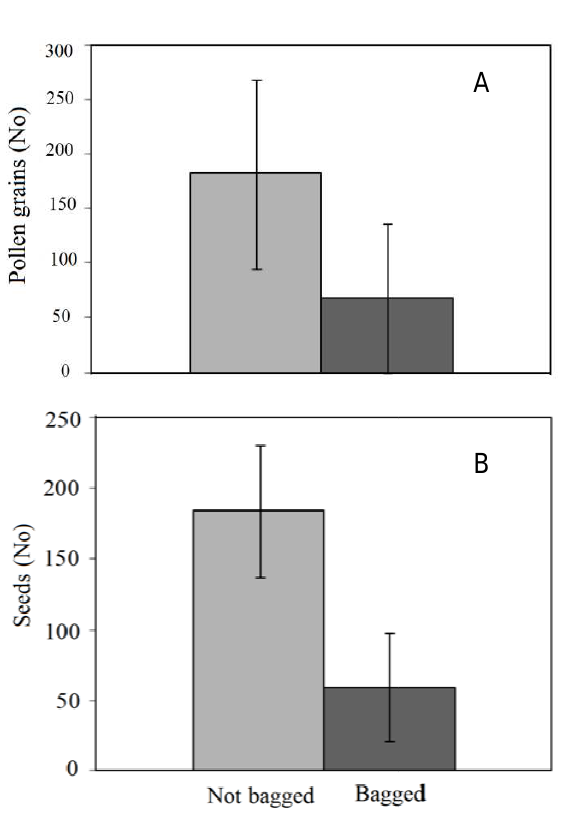
F IGURE 1. (A) Mean number (± SE) of pollen grains on the Mean number (± SE) of pollen grains on the stigma of bagged and non bagged flowers. Compared with paired stigma of bagged and non bagged flowers. Compared with paired P = 0.0000). (B) Student's t -test at 95% significance (t = 5.678; Mean number (± SE) of seeds in the fruit of bagged and non number (± SE) of seeds in the fruit of bagged and non bagged flowers. Compared with paired Student's bagged flowers. Compared with paired Student's t -test at 95% significance (t = 12.37; P = 0.000). The fruit set was on average 64.48% (t = 9.55; P = 0.000)